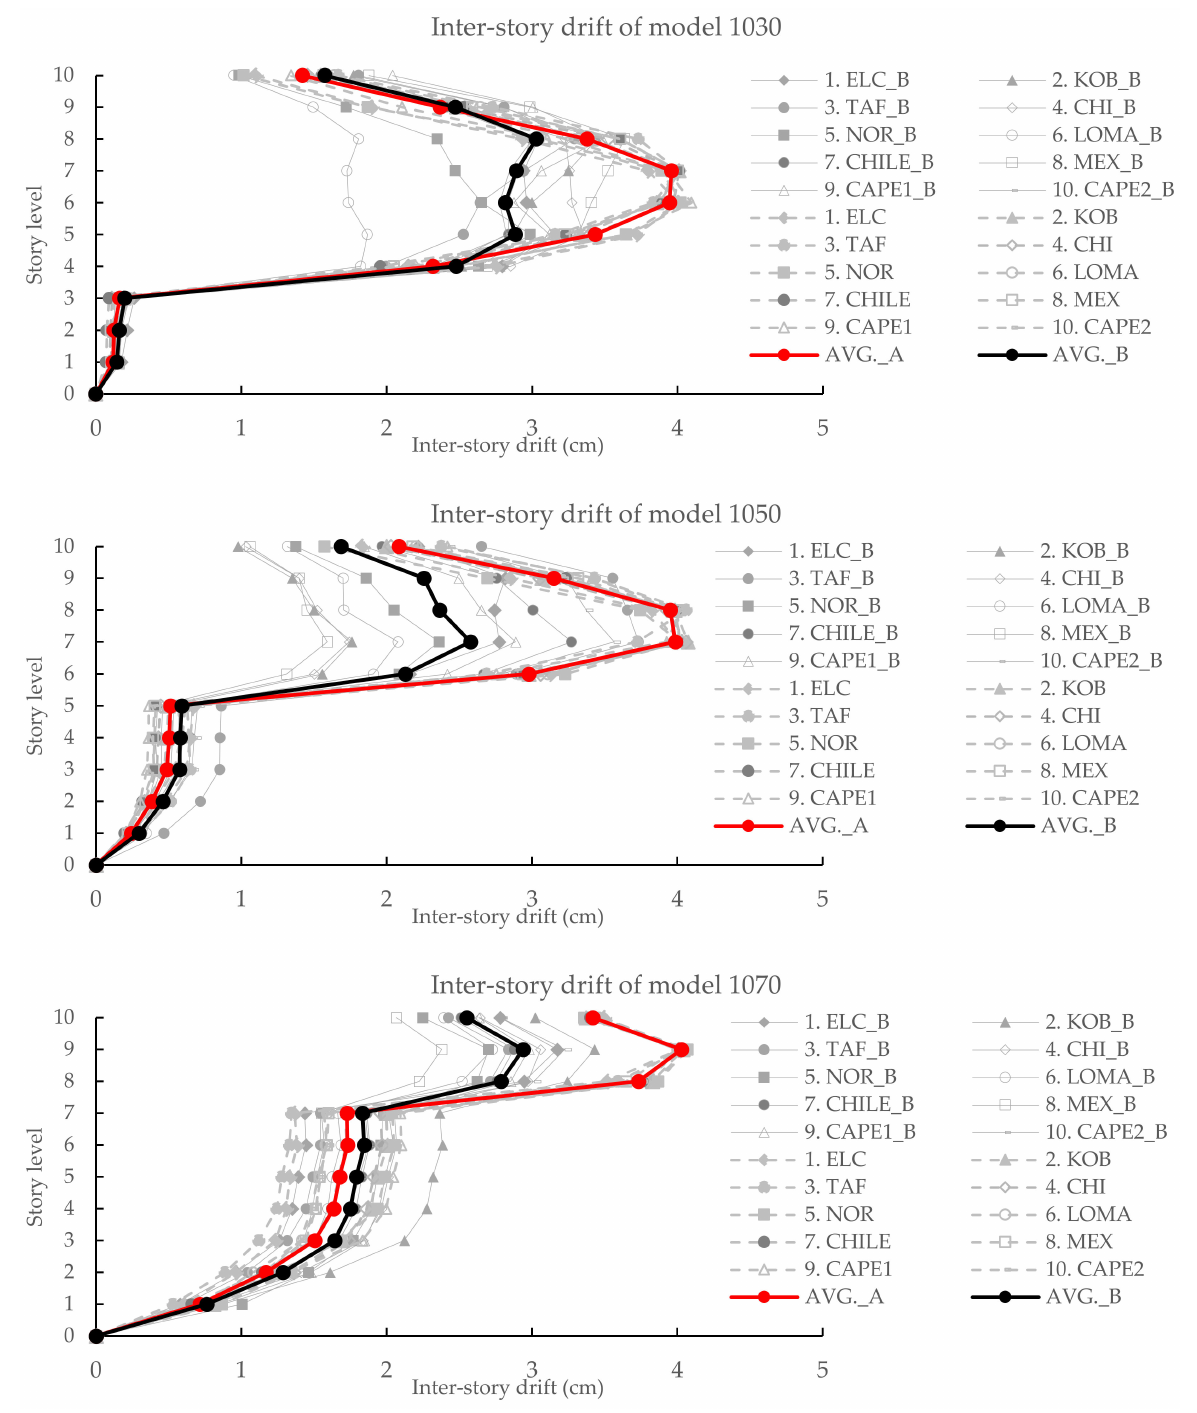
Figure 22. Comparison of inter-story drift distribution of frame-curtailed wall structure without BRBs and with BRBs for 10